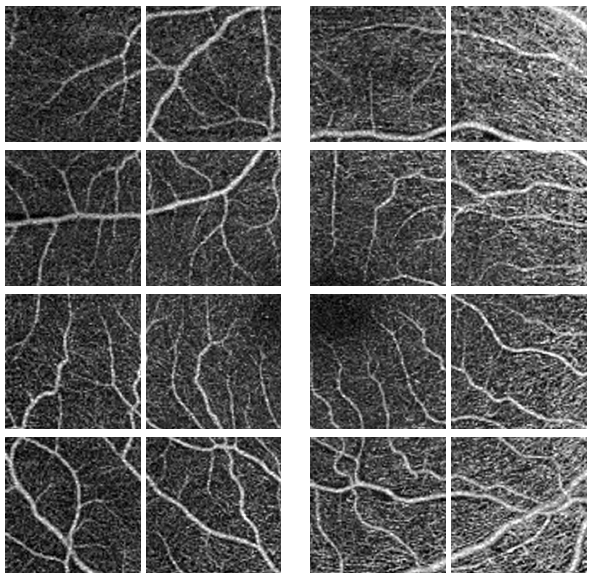
Figure 4. Normal OCTA image splitting for 16 equal size (256 × 256)